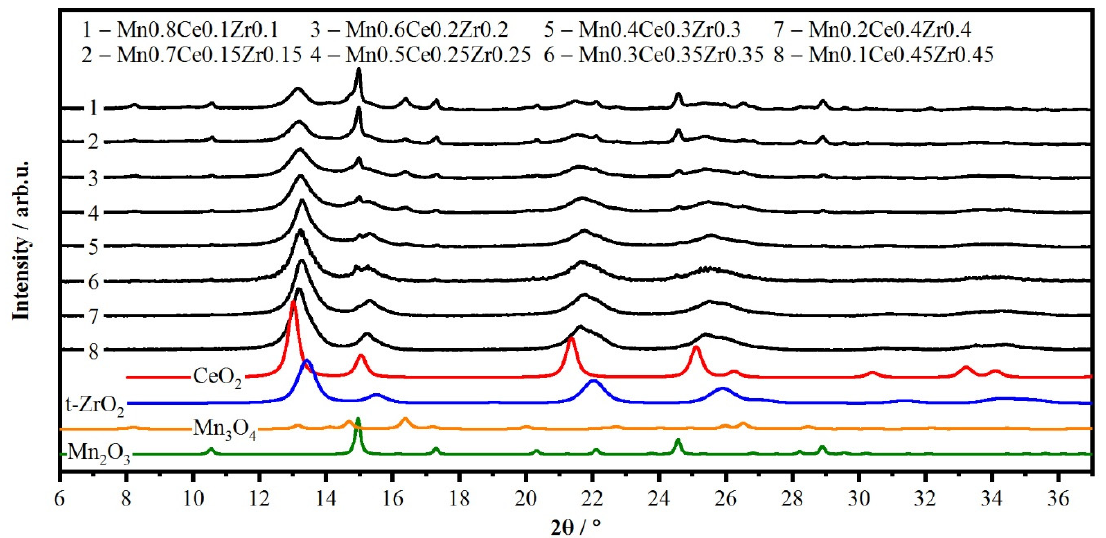
Figure 6. XRD patterns of Mn(x)Zr(0.5 − x/2)Ce(0.5 − x/2) catalysts and peak positions of phases CeO 2 (PDF No. 431002), t-ZrO 2 (PDF No. 42-1164), Mn 2 O 3 (PDF No. 41-1442), and Mn 3 O 4 (PDF No. Table 3. Phase composition, lattice parameter of solid solution, CSR, and surface area for